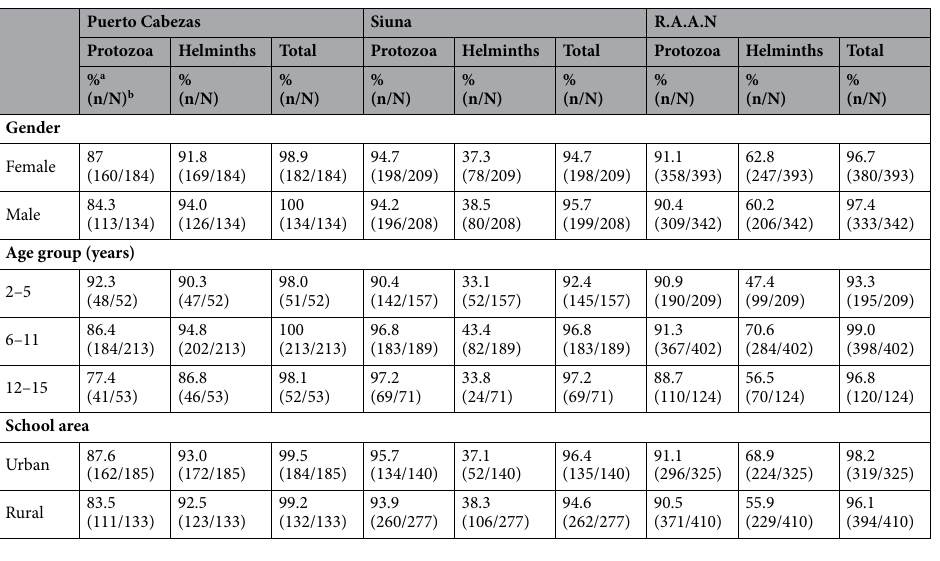
Table 2. Prevalence results of protozoa, helminths, and total infection according to gender, age group and urban/rural school area obtained in both municipalities studied and in the total R.A.A.N. (Nicaragua). a Percentage. b Positive students/total students in the